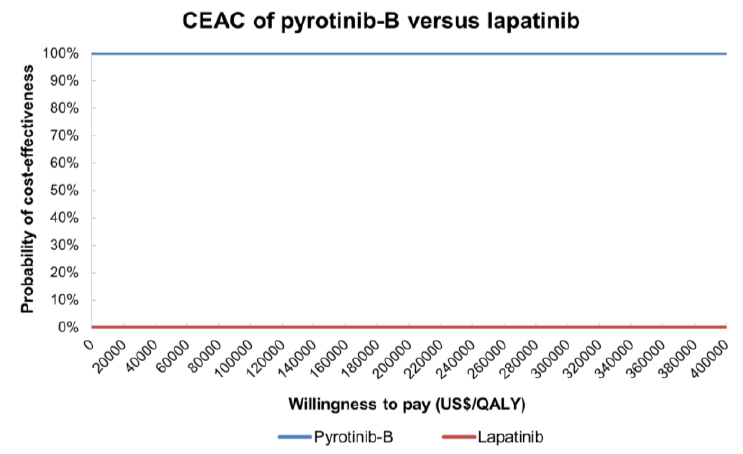
Figure 6. Cost-effectiveness acceptability curve between pyrotinib-B plus capecitabine and lapatinib plus capecitabine. Notes: Blue line indicates pyrotinib-B regimen, and red line indicates lapatinib regimen. Abbreviations: CEAC, cost-effectiveness acceptability curve; pyrotinib-B, pyrotinib after being enrolled in National Reimbursement Drug List; QALY, quality-adjusted life-year.